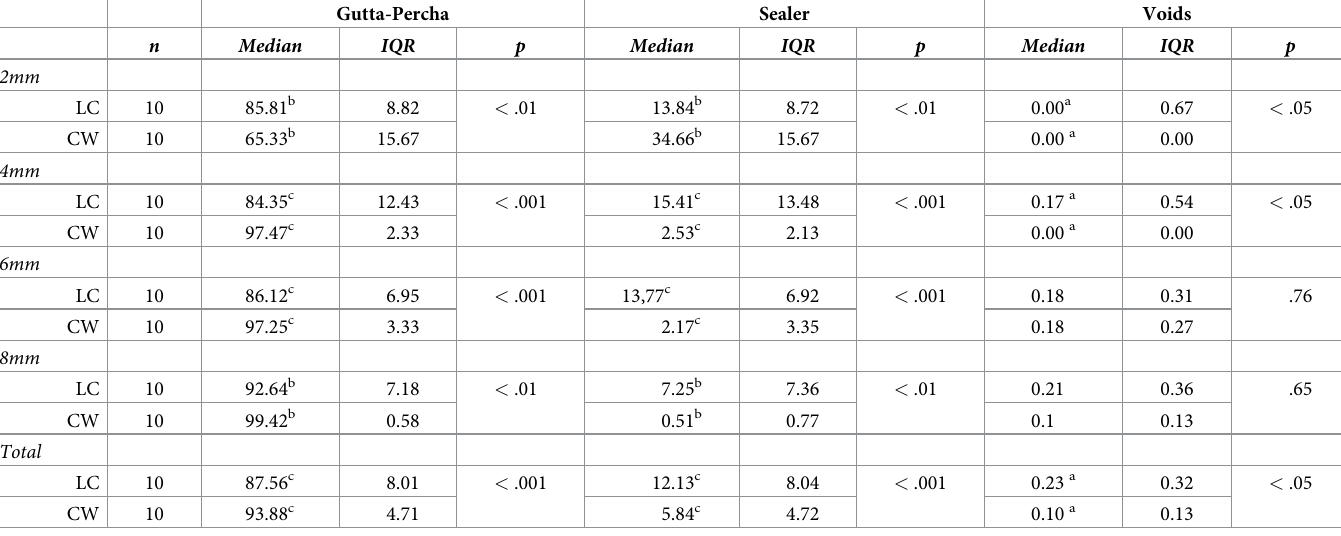
Table 4. Descriptive statistics and Kruskal-Wallis test results on the percentages of gutta-percha, sealer and voids according to level of sections independent from shaping system in C1-type.